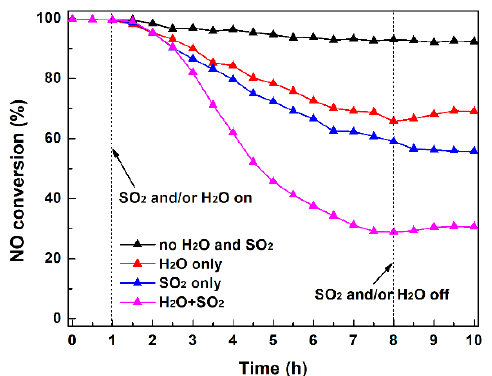
Figure 2. Effect of SO 2 and/or H 2 O on the NH 3 -SCR activity of Ce 0.2 W 0.2 Ti at 300 °C. Reaction conditions: [NO] = [NH 3 ] = 500 ppm, [O 2 ] = 5%, [SO 2 ] = 500 ppm, [H 2 O] = 5%, balanced N 2 , GHSV = 120,000 mL·g − 1 ·h − 1 .